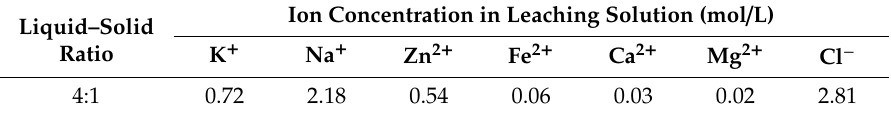
Table A1. Ion concentration in RHF secondary dust water immersion solution.